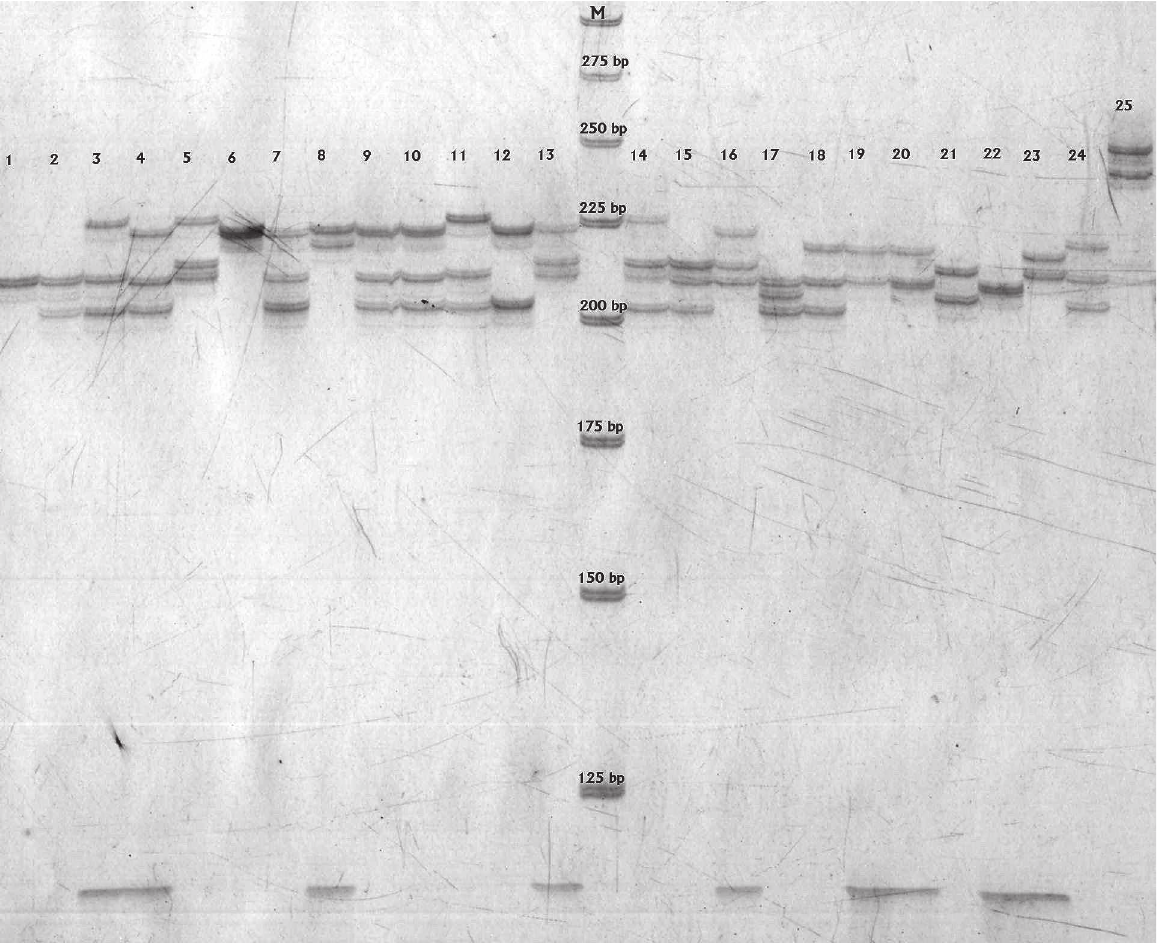
Fig. 1. Example of microsatellite DNA variation at locus Spl-168 in studied specimens of Siberian sturgeon, Acipenser